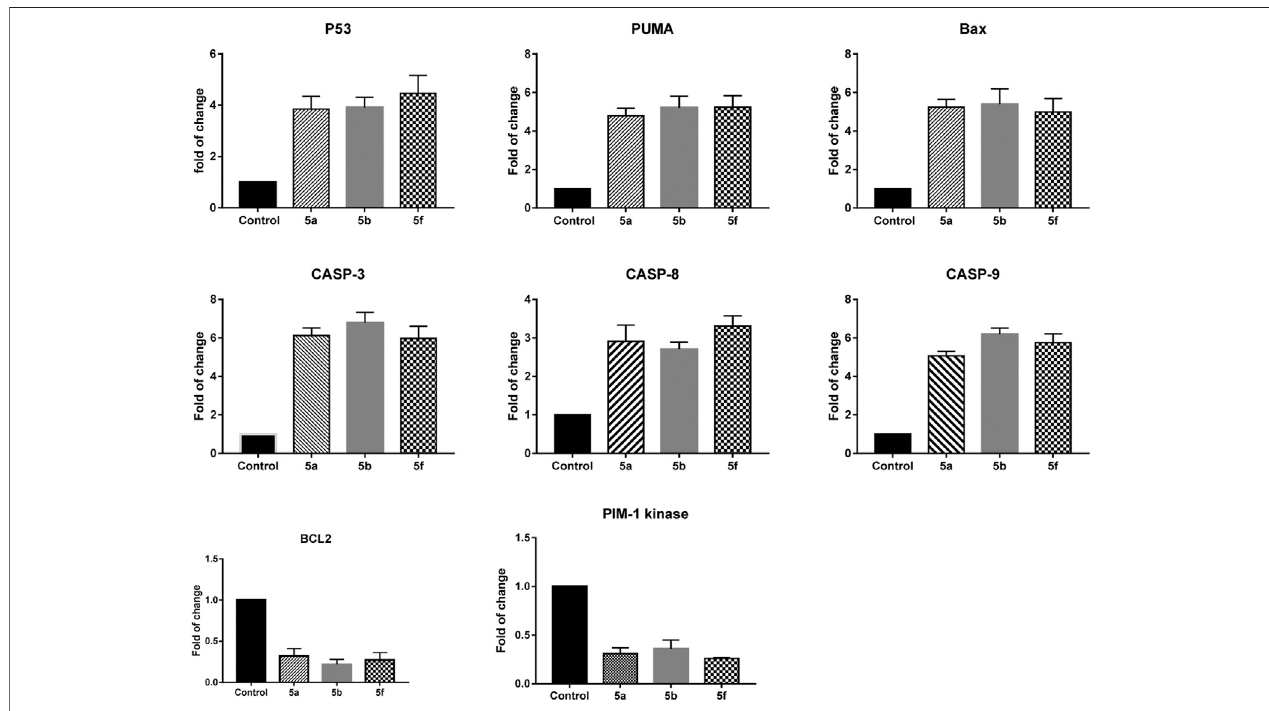
FIGURE 3 | Quantitative RT-PCR result analysis of the apoptosis-related genes: p53, bax, puma, caspases 3, 8, and 9, Bcl-2, and Pim-1 kinase, respectively, in KF-28 cells treated with some selected compounds 5a, 5b, and 5f for 48 h of incubation.